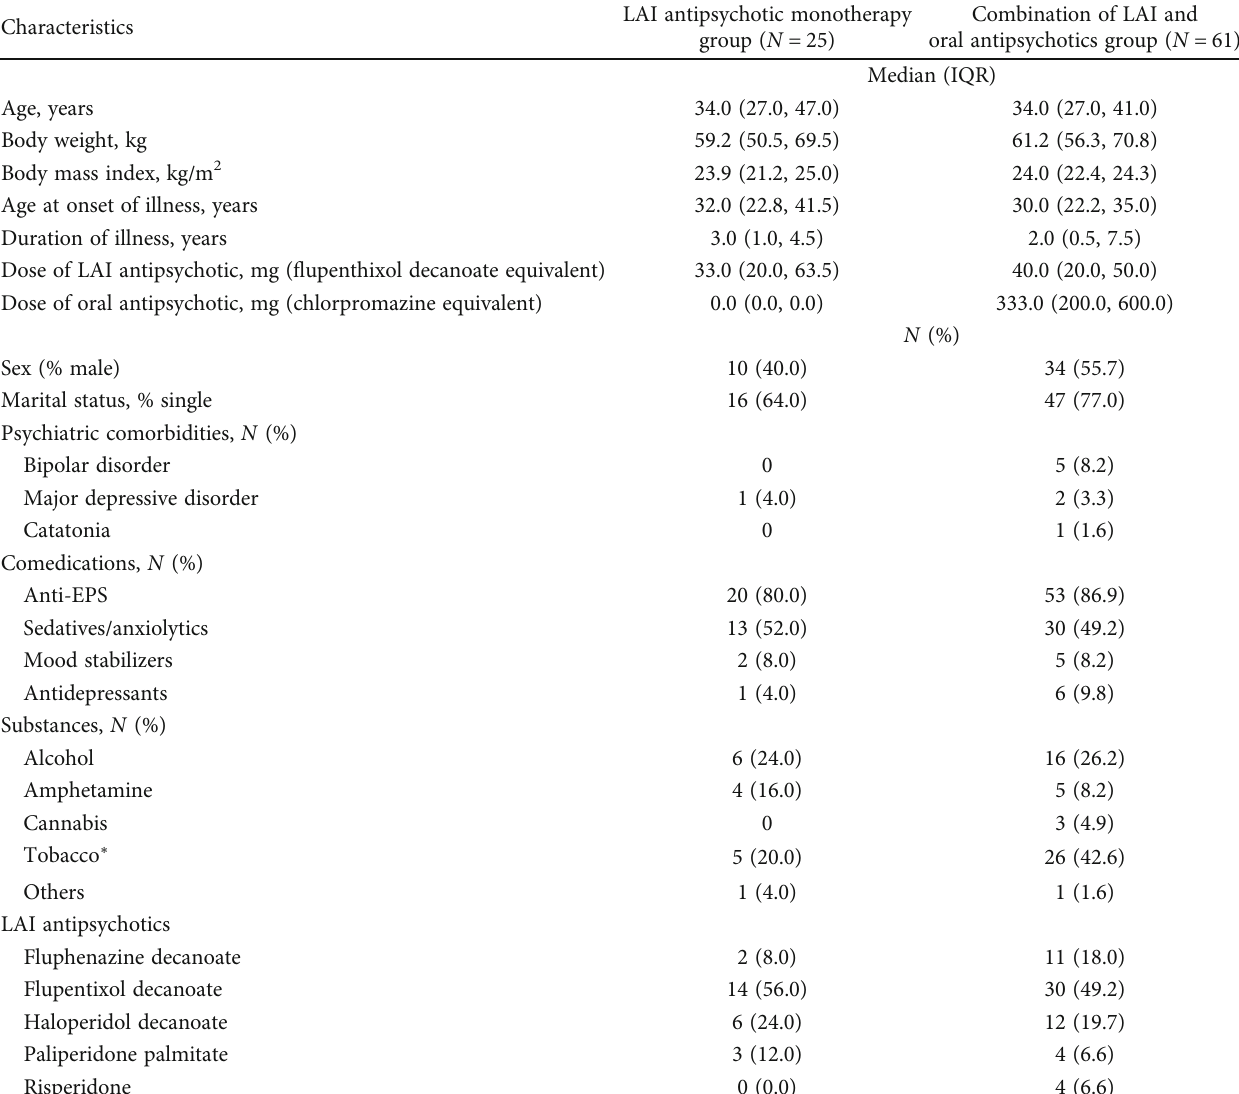
Table 1: Baseline characteristics of the study